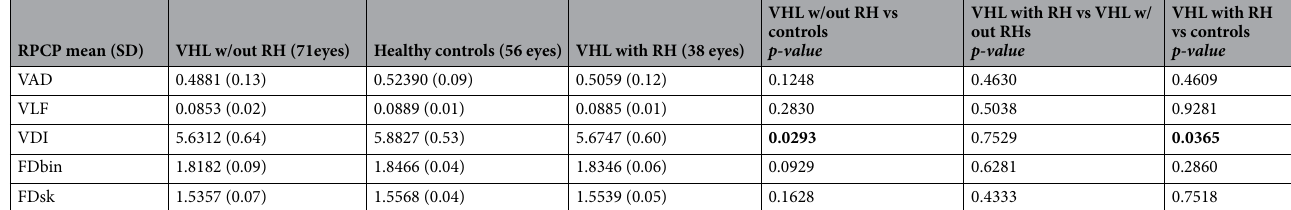
Table 2. OCT angiography parameters of the Radial Peripapillary Capillary Plexus (RPCP) in VHL eyes with or without RH and healthy controls. FDbin, Fractal Dimension of binary image; FDsk, Fractal Dimension of skeletonized images; RH, retinal hemangioblastomas; VAD, Vascular Area Density; VDI, Vessel Diameter Index; VHL:Von Hippel-Lindau Disease; VLF, Vessel Length Fraction. Significant p value in bold.